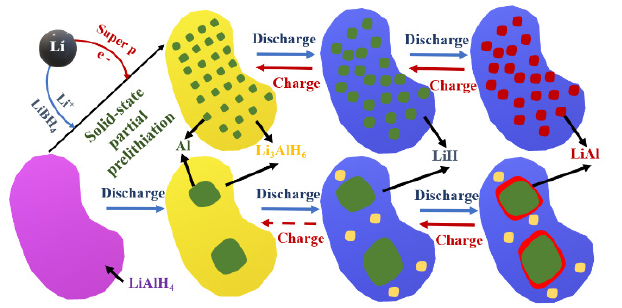
Figure 6. Schematic illustration of the structural evolution of the solid state partial prelithiation (SSPP) LiAlH anode and LiAlH 4 anode during cycling in LIBs, based on [48].